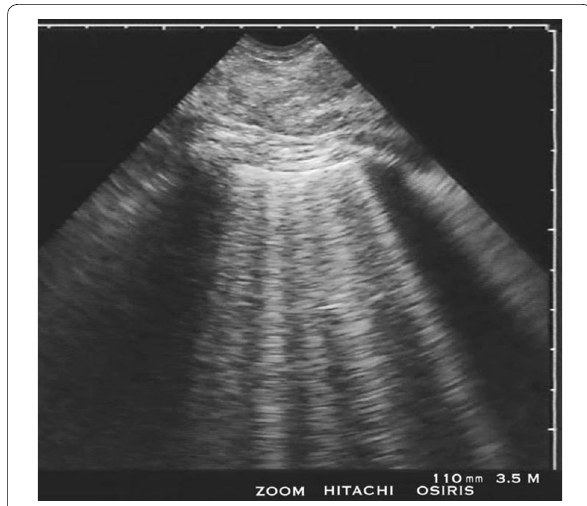
Fig. 2 One main impact of the BLUE-protocol is the diagnosis of pulmonary edema, highly suggested when lung rockets are harmoniously distributed anteriorly. The association with lung sliding generates the B-profile, suggesting hemodynamic pulmonary edema with a 97% sensitivity and a 95% specificity